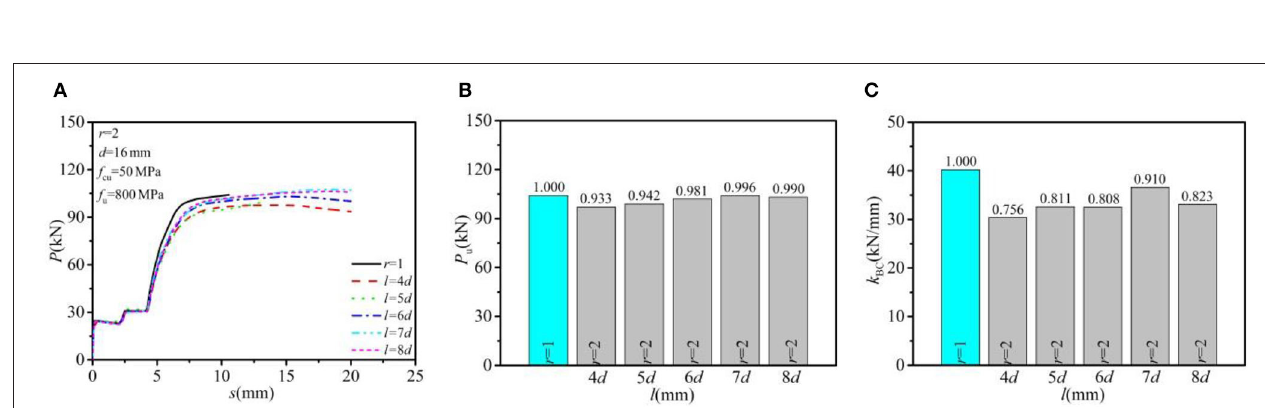
FIGURE 6 | Comparison of failure modes between MBSCs and normally arranged bolted connector: (A) Von Mises stress of bolt connector ( r = 1); (B) von Mises stress of MBSCs ( r = 4); (C) bolt shear failure ( Yang et al., 2020); (D) compression damage of slab ( r = 1); and (E) compression damage of the slab ( r = 4).